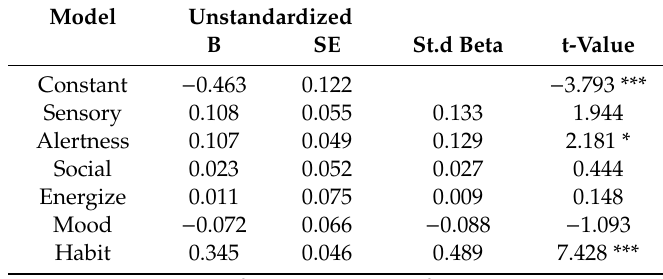
Table 6. Results of regression analysis of motivations influencing co ff ee consumption.